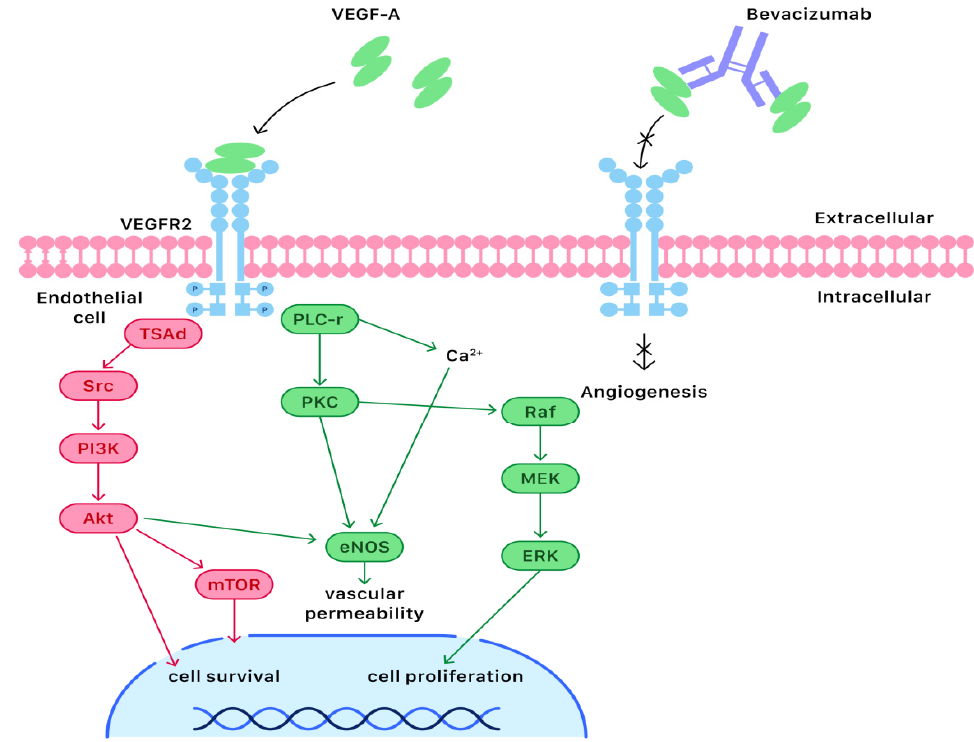
Figure 2. The molecular and cellular mechanisms of bevacizumab in angiogenesis of cancer